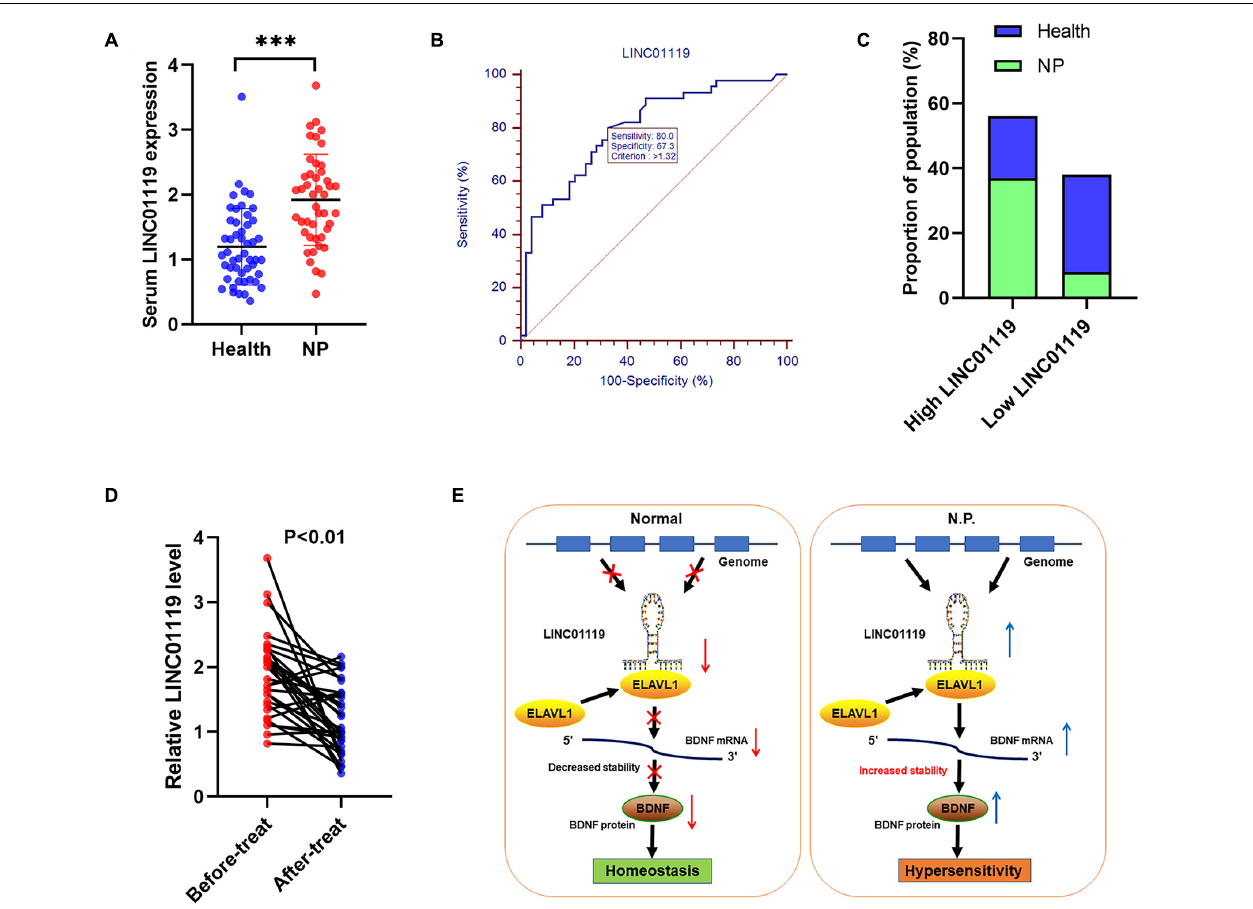
FIGURE 6 | LINC01119 is a promising diagnostic marker for NP patients. (A) LINC01119 expression was detected in serum samples from 45 NP patients (PHN) and 49 healthy people by qRT-PCR, ∗∗∗ P < 0.001. (B) ROC curve was established to evaluate the diagnostic performance of serum LINC01119 level. (C) The proportions of NP patients and healthy people in high or low-LINC01119 groups were shown. (D) Serum LINC01119 level were determined in 45 NP patients before and after treatment. (E) Schematic diagram of LINC01119 induces NP through regulating BDNF expression in an ELAVL1-dependent manner.